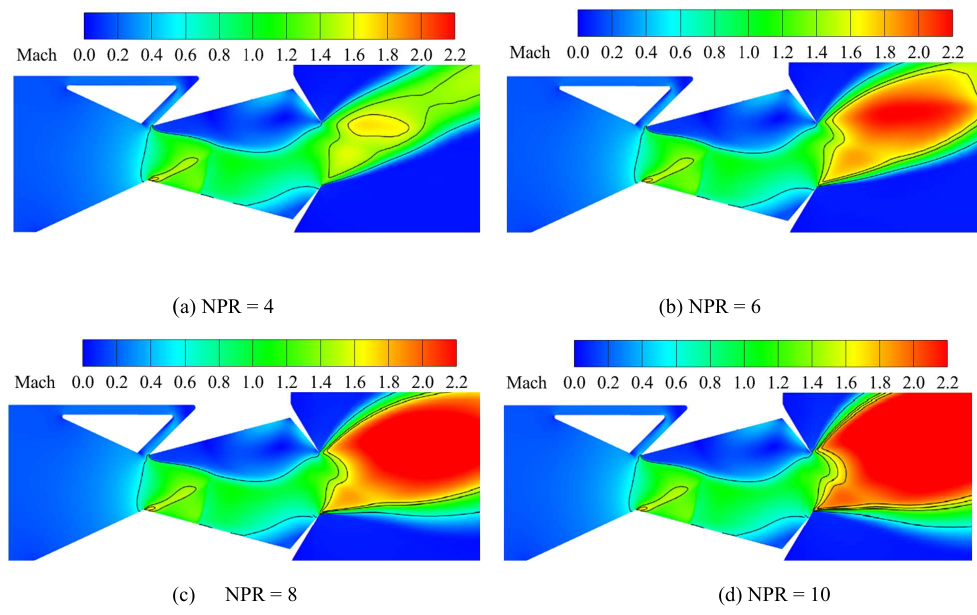
Figure 12. This represents the Mach contours at θ 1 = 25 ◦ , θ 2 = 45 ◦ , and h b /h t = 0.185 for different NPR.